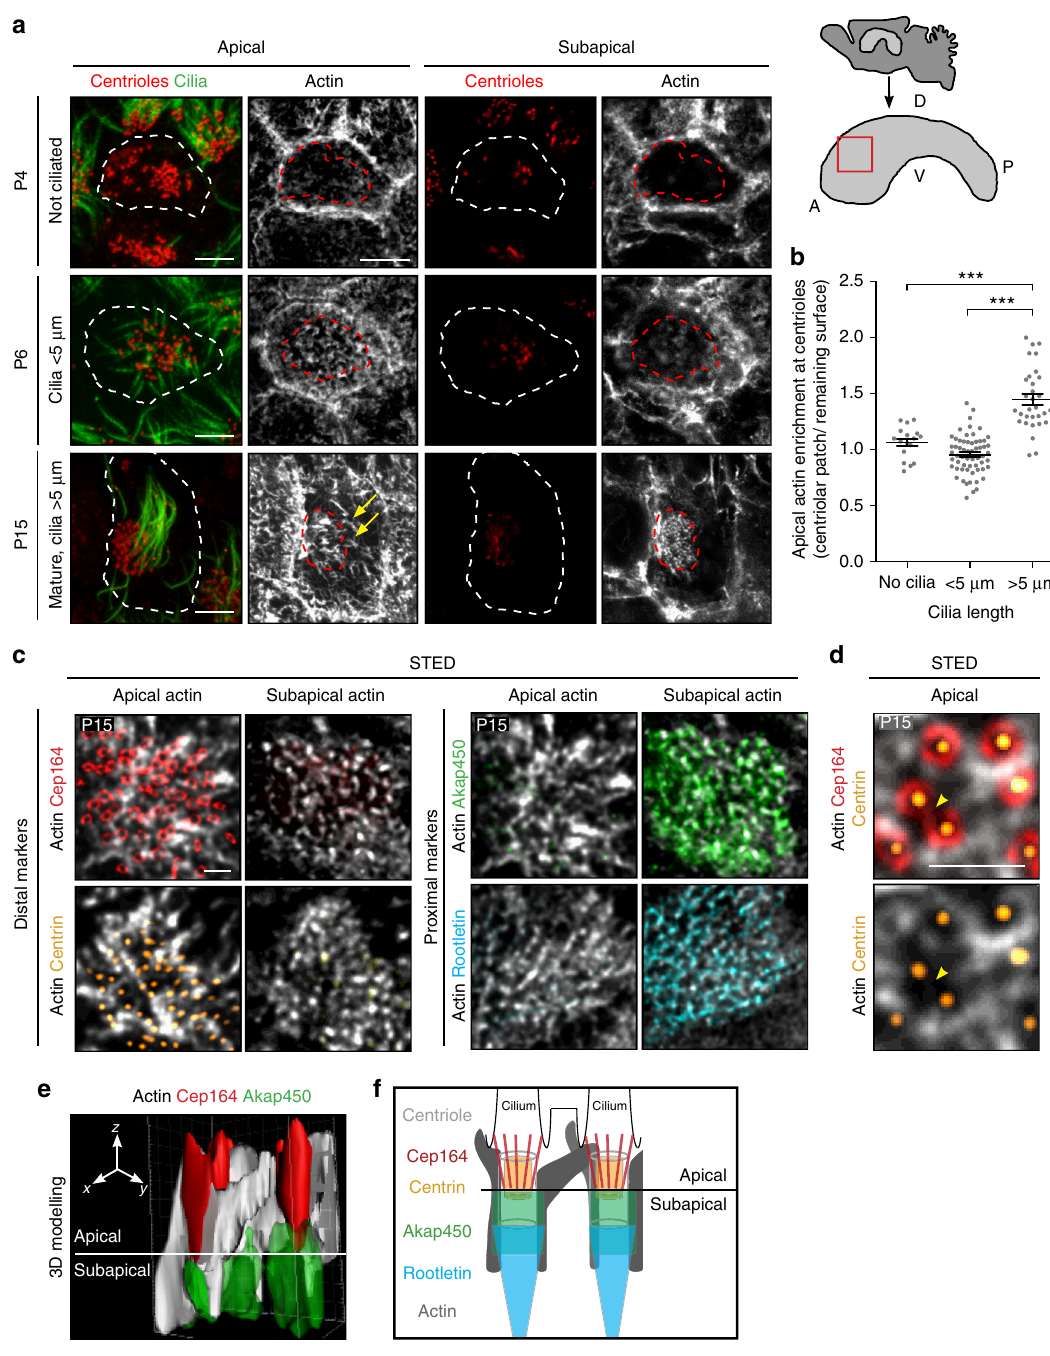
Fig. 1 Formation of a dense actin network at the centriolar patch during ependymal cell differentiation a F-actin (phalloidin, grey), centrioles (FOP, red) and cilia (GT335, green) in whole mounts of lateral ventricular walls at postnatal days 4 (P4), P6 and P15 at the apical level (colocalising with FOP staining) and subapical level; the actin network in the centriolar patch thickens as motile cilia grow; cell borders and centriolar patches are outlined with dashed white and red lines, respectively. Arrows point to long actin fi laments. On the right, a sagittal view of the lateral ventricular wall and the region of interest analysed throughout the paper (red square); A: Anterior, P: Posterior, D: Dorsal, V: Ventral. b Ratio of mean phalloidin fl uorescence intensities in the centriolar patch (red dashed lines in a ) and on the remaining cell surface (white minus red dashed lines) as a function of ciliary length. Error bars represent the sem of n = 112 cells from three mice; P -values were determined by one-way ANOVA followed by Dunn ’ s multiple comparison test; *** P ≤ 0.0001. c – e High resolution microscopy (STED) of mature ependymal cells on P15 whole-mount lateral ventricular walls. c Staining of F-actin (phalloidin, grey) and centriole distal markers, Cep164 (distal appendages, red) or Centrin2-GFP (distal lumen, yellow) that colocalise with the apical actin network, or centriole proximal markers Akap450 (pericentriolar material, green) or Rootletin (rootlets, cyan) that colocalise with the subapical actin network. d Zoom- in of Cep164 (red)-, Centrin2-GFP (yellow)- and F-actin (phalloidin, grey)-labelled mature ependymal cells; note a cluster of two centrioles with merged distal appendages (arrowhead) surrounded by actin. e Three-dimensional modelling of Cep164 (red)-, Akap450 (green)- and F-actin-(grey)-positive centrioles showing the links between the apical and subapical networks, and between neighbouring centrioles. f Model of centrioles with their associated actin bundles positioned according to the markers used in this study. Scale bars = 5 μ m in a and 1 μ m in c ,